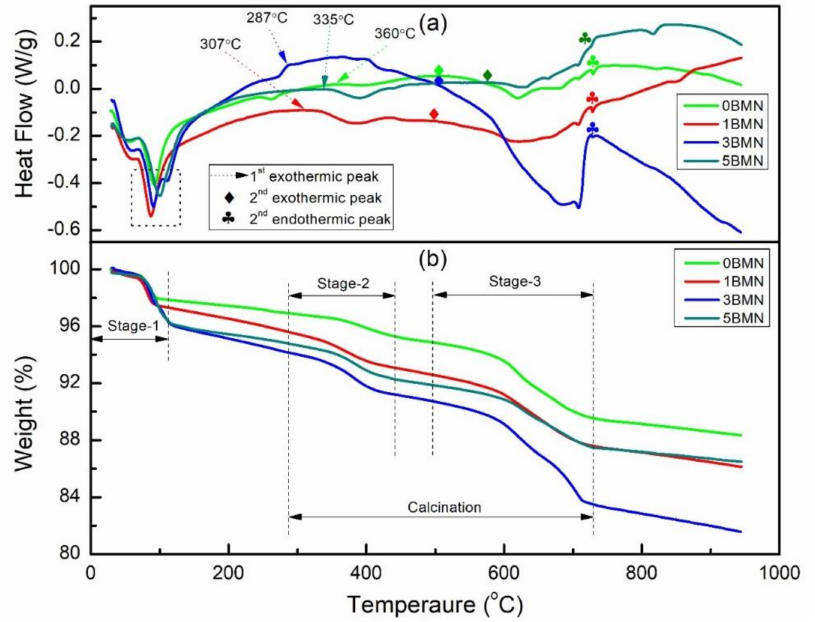
Figure 1. ( a ) DSC and ( b ) TGA of uncalcined